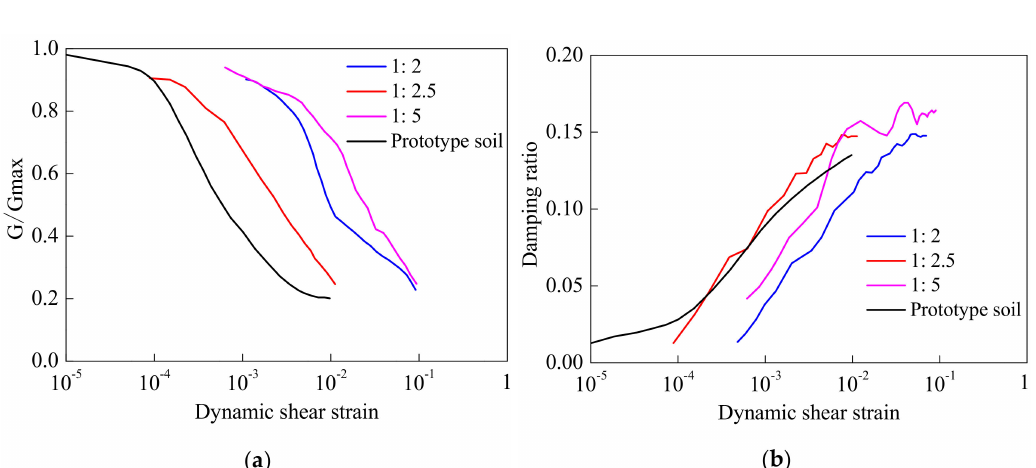
Figure 2. Dynamic characteristic curves of soils. ( a ) Dynamic shear modulus ratio versus shear strain.( b ) Damping ratio versus shear